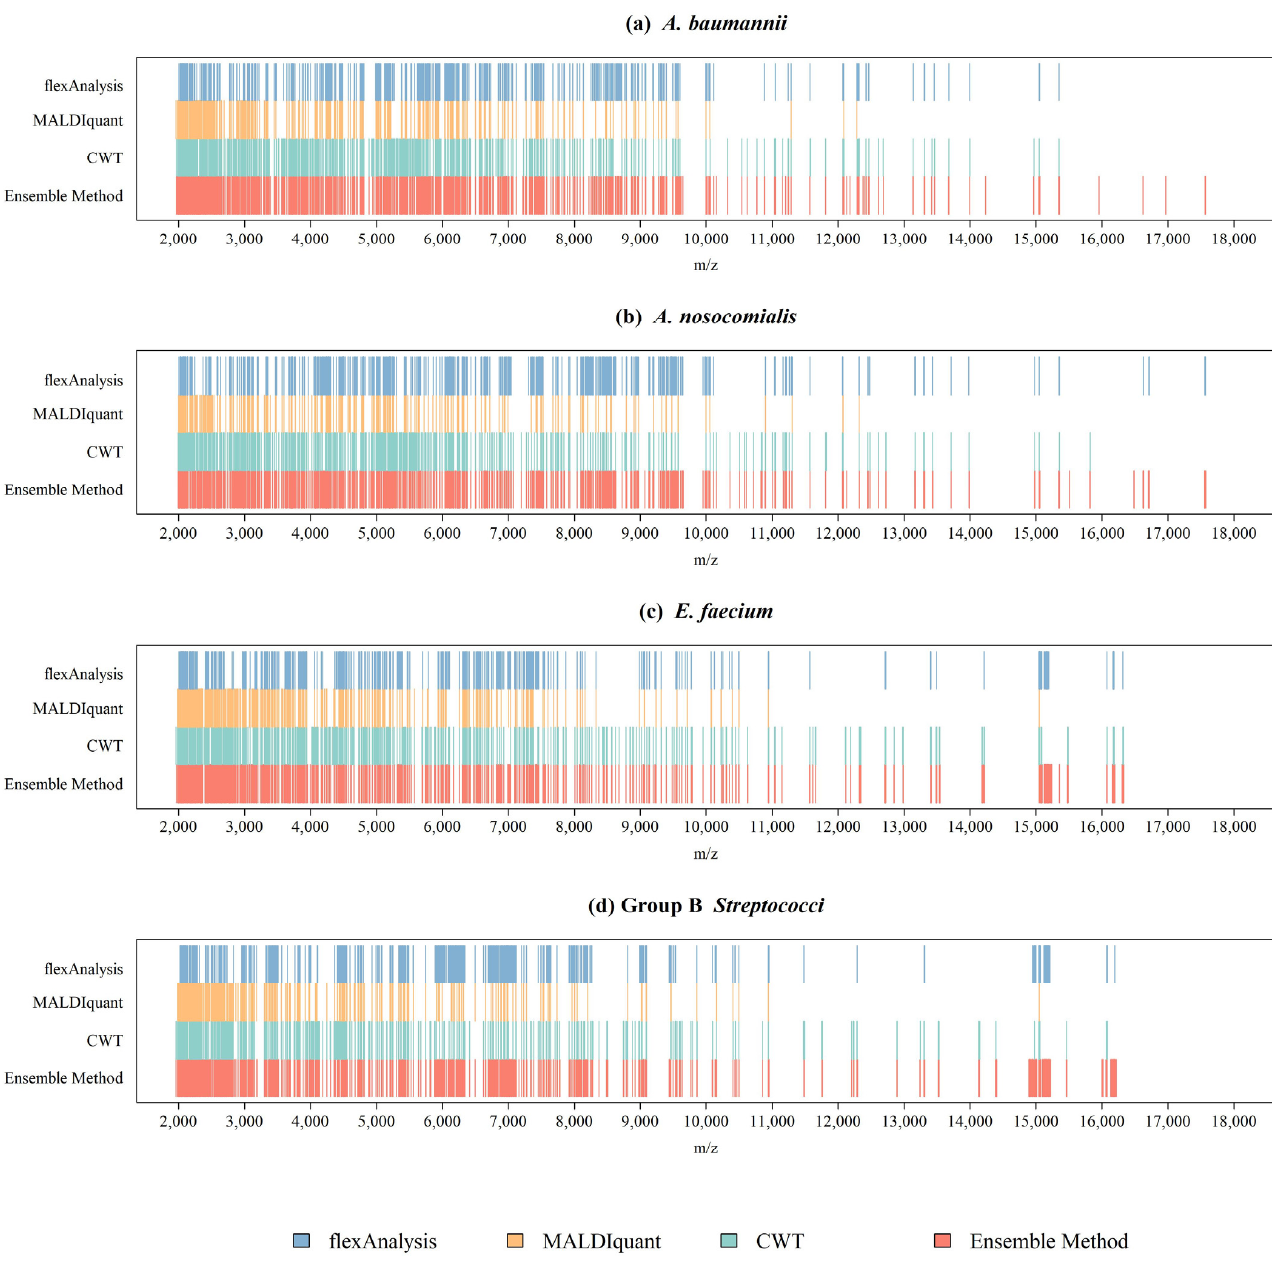
Figure 2. Distributions of benchmark peaks with different preprocessing methods for ( a ) A. baumannii , ( b ) A. nosocomialis , ( c ) E. faecium , and ( d ) Group B Streptococci .